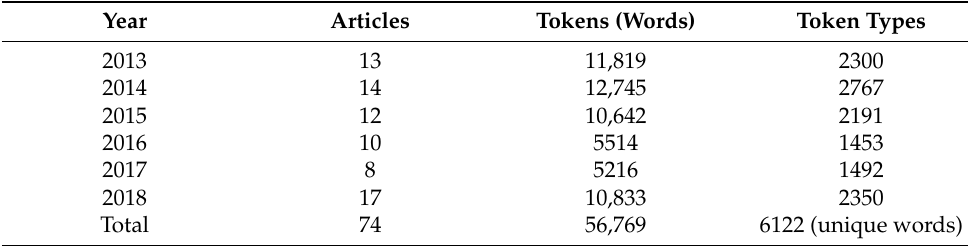
Table 3. Number of articles included from year 2013 to 2018.